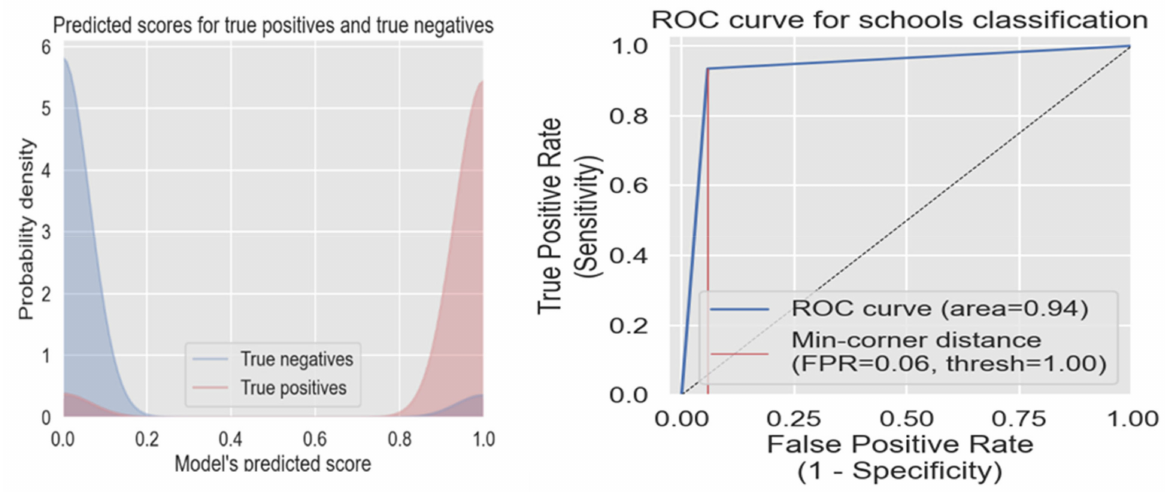
Figure 13. True positive, true negative scores, and ROC curve of the Kenyan model. By plotting the results from the Kenya model, inferences with the Kenya country, East African regional and global models, we found that the regional model outperformed the country model in that it produced fewer ML-detected schools (Figure 14-blue bar), which means fewer false positives. It was able to detect more schools (the red bar) that fell under unknown